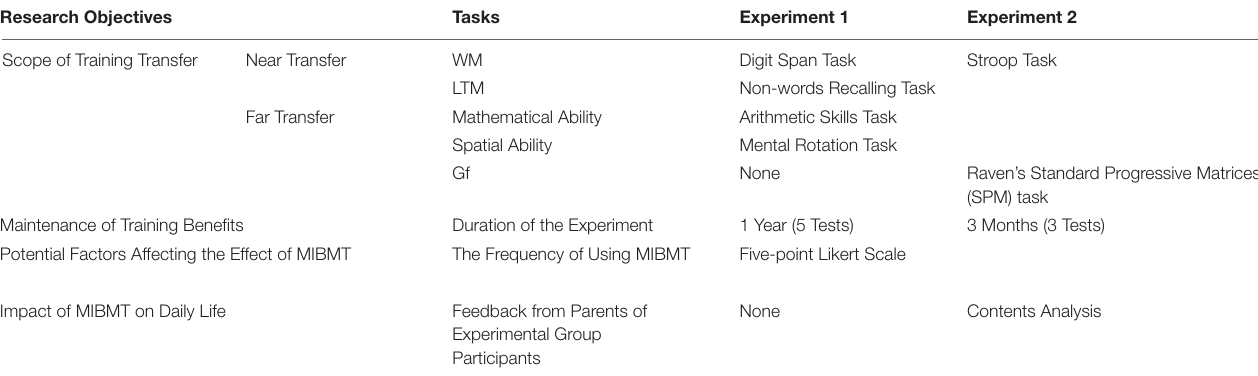
TABLE 2 | Overview of the experiments.